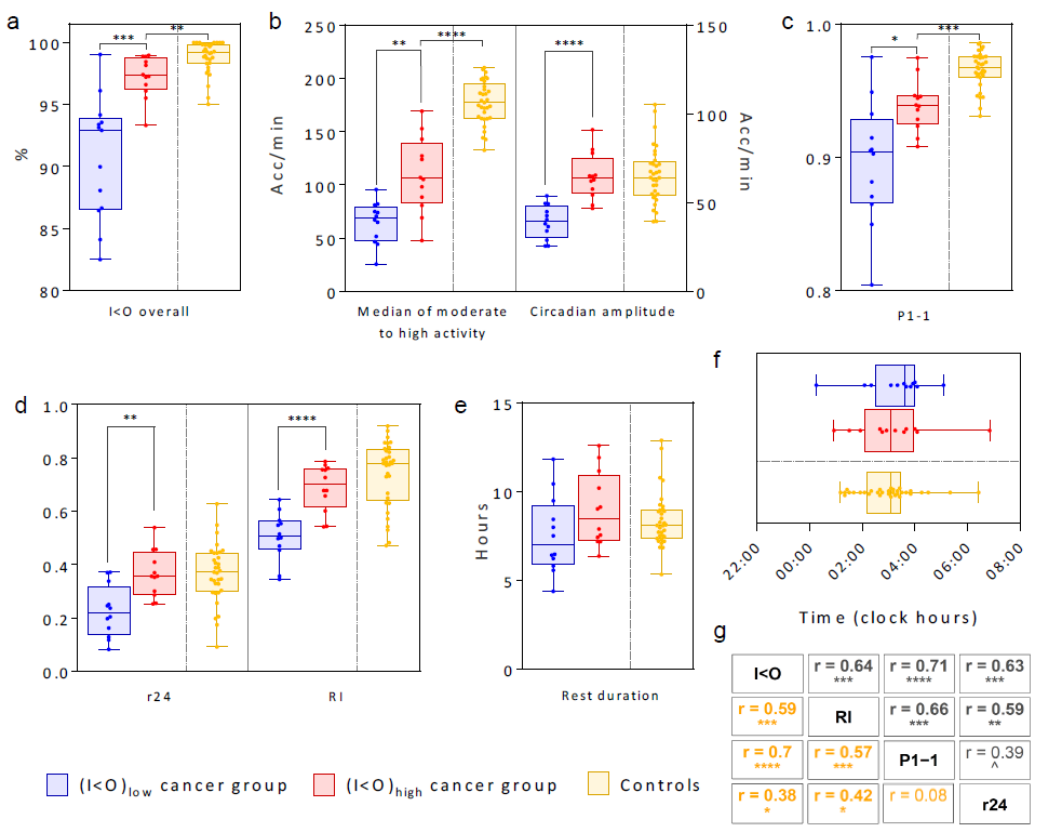
Figure 3. Box plots comparing the main parameters of the tele-transmitted rest-activity patterns in (I < O) low and (I < O) high cancer groups, and in the controls. ( a ) Box plots of I < O values computed over 7 days for each I < O patient group and controls. ( b ) Median of MA and HA activity states and circadian amplitude (spectral analysis). ( c ) P1-1 (HMM). ( d ) R24 and Rhythm Index. ( e ) Estimated rest duration. ( f ) Center-of-rest time. ( g ) Correlation matrices of the rest-activity rhythms parameters for cancer patients (black) and controls (yellow). In ( a – e ), the bars represent the extremes and bold lines inside the box plots plot median levels. Values for each individual are plotted as jittered dots to better show the distribution. Levels of significance: **** p ≤ 0.0001; *** 0.0001 < p ≤ 0.001; ** 0.001 < p ≤ 0.01; * 0.01 < p ≤ 0.05; ˆ 0.05 < p ≤ 0.1 (two-tailed Welch’s modified t -test ( a – e ); Pearson’s correlation ( f)).